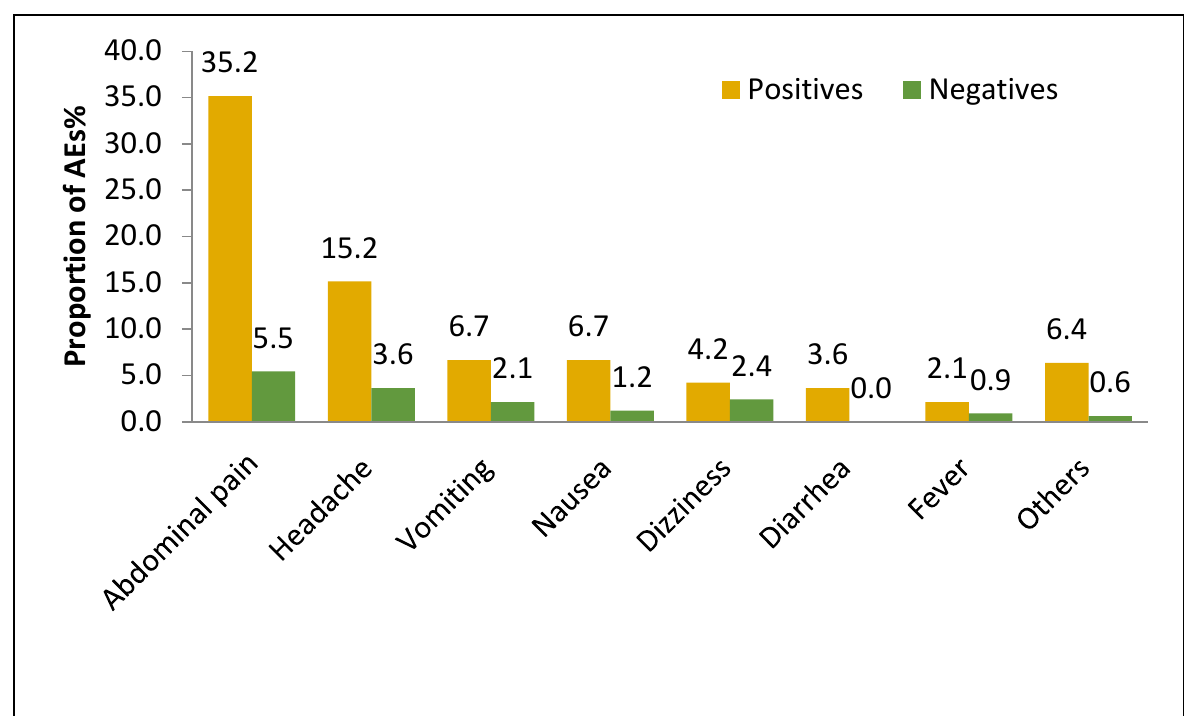
Figure 4. Proportions of AEs among the prescreened participants stratified by S. mansoni or STH